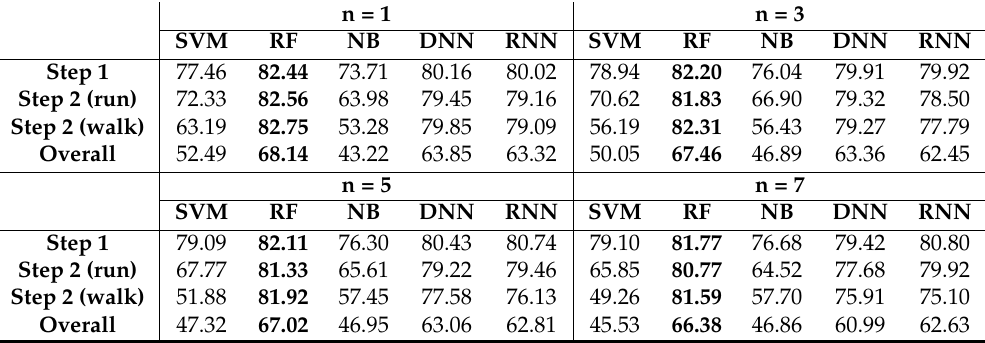
Table 7. Accuracies of action-possession recognition for different number of windows.